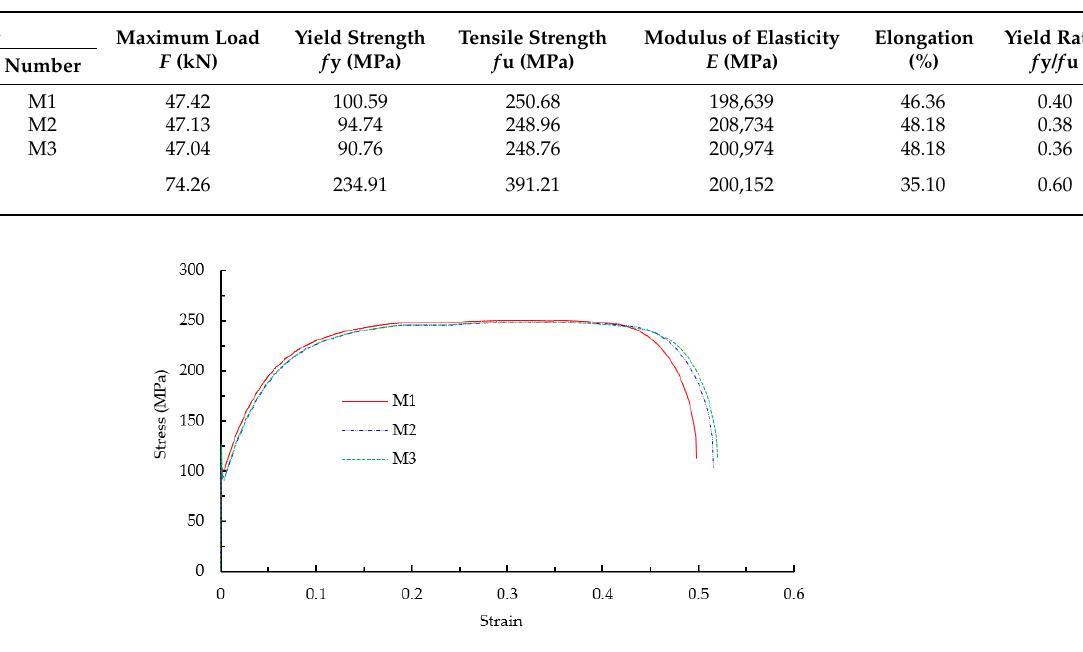
Table 3. Results of the material test.